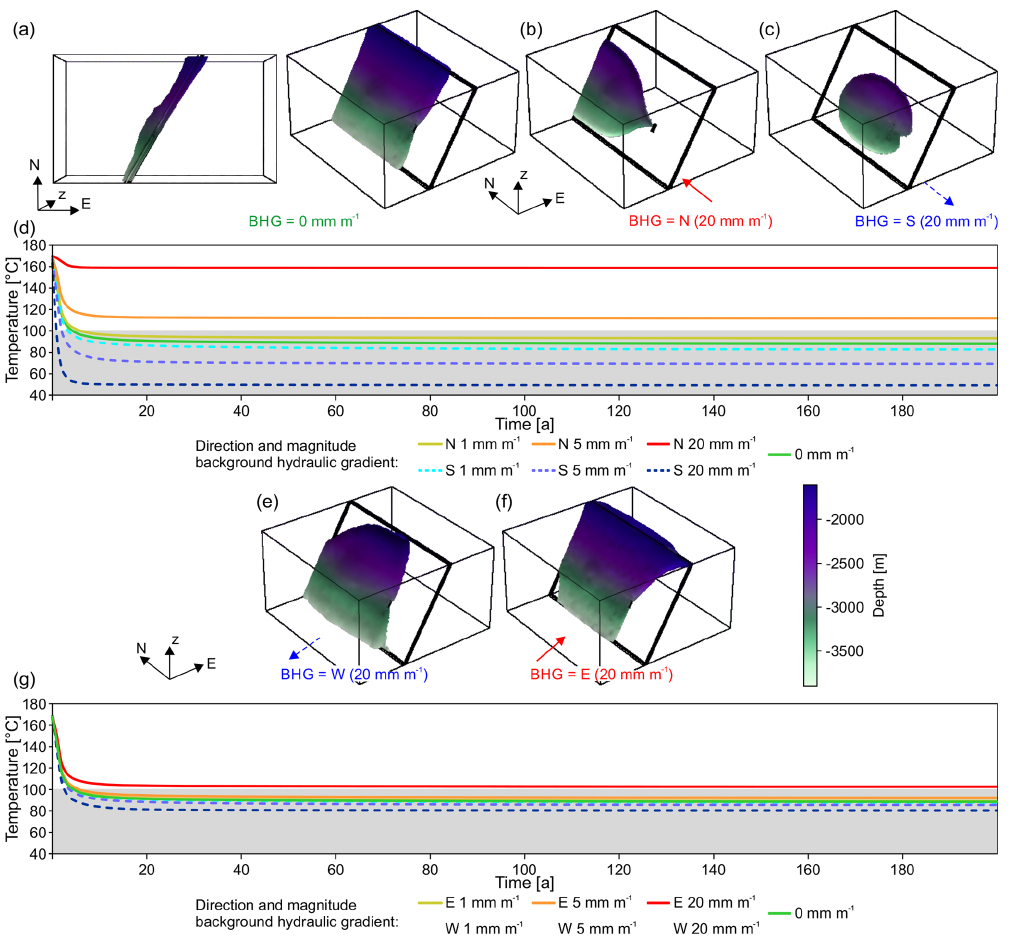
Figure 9. Temperature development and shape of the HDI for faults consisting of a damage zone with fault-parallel fracture anisotropy and an impermeable fault core. In (a) , (b) , and (c) , the shapes of the HDI after 100 years for fault-parallel BHGs are shown. The HDIs are entirely restricted to the western damage zone. Their shape within the fault zone varies significantly, depending on the BHG. Panels (d) and (g) show the temperature development over time of the produced fluid and contain the results of 13 individual simulations. Panel (d) shows how the northward BHGs completely suppress temperature drops at the production well and southward BHGs lead to immediate depletion of the reservoir. In (e) and (f) , shapes of the HDI for BHGs normal to the strike of the fault after 100 years are